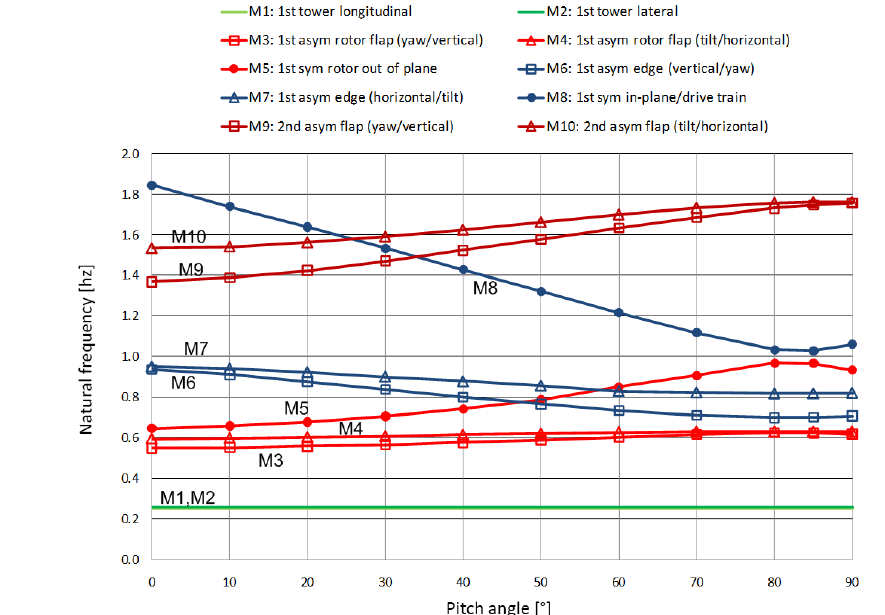
Figure 1. Natural frequencies of the 10MW reference wind turbine versus pitch from 0 to 90 ◦ (towards feather).